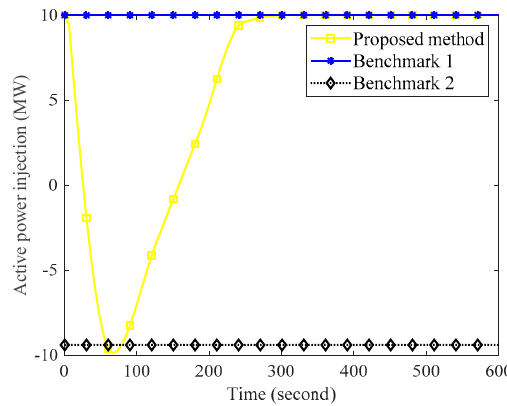
Figure 4. The total active injection of all 33-bus systems.